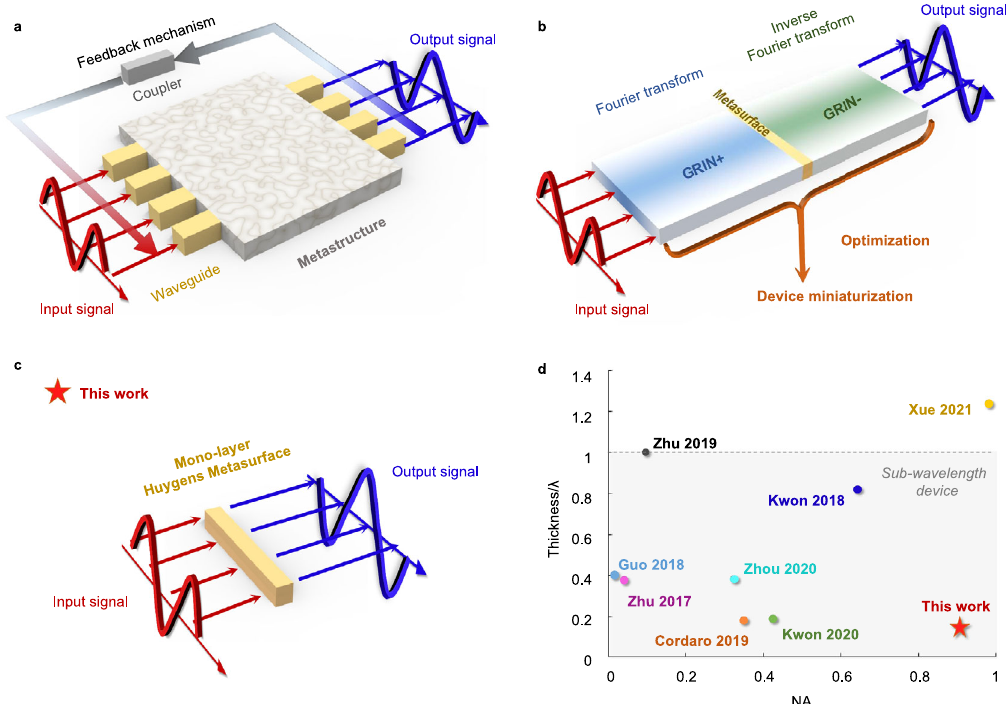
Fig. 1 Conceptual sketch of representative analog metaprocessors. a Solving integral equation by a closed-loop network consisting of the metamaterial kernel, directional couplers and in/out waveguides. b Spatial analog computing based on the 4 f Fourier optics system. (GRIN + indicates a conventional GRIN, operates as a Fourier transformer. GRIN − has the inverse functionality of the GRIN + , which acts as an inverse Fourier transformer). c The proposed single-layer meta-processor in this work for shrinking the bulky Fourier-based designs. d Comparison of the proposed differentiator to the recently proposed designs 5,24,26,31 – 34